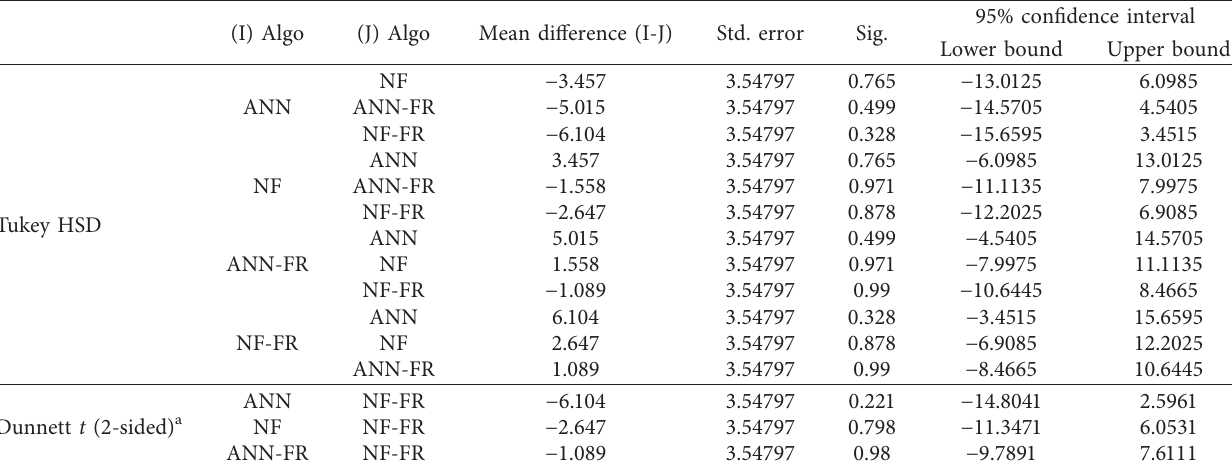
Table 8: Tukey test and Dunnett test.